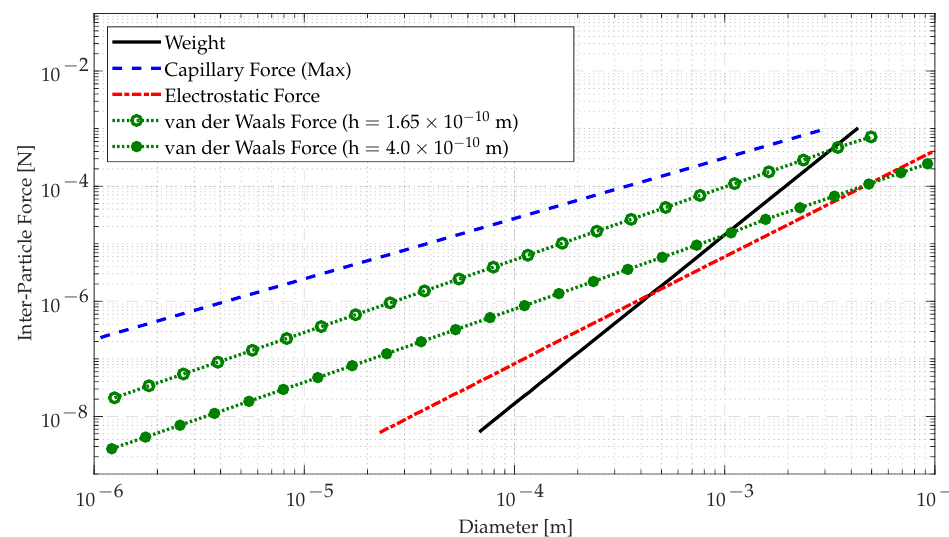
Figure 1. Comparison of theoretical inter-particle force magnitudes (adapted from [17]). Reproduced with permission from Powder Technology; published by Elsevier,